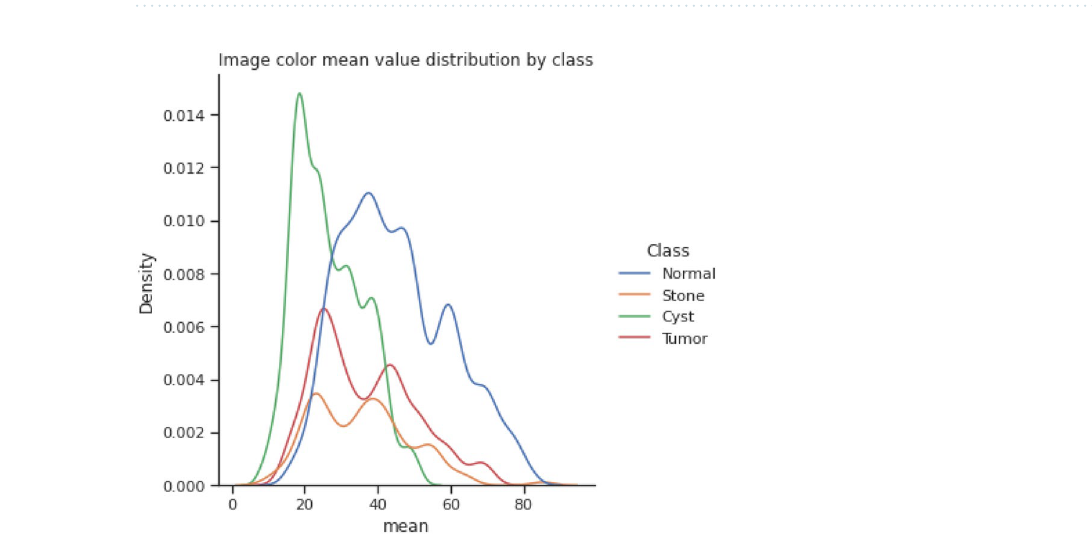
Figure 4. Image colour mean value distribution by class.